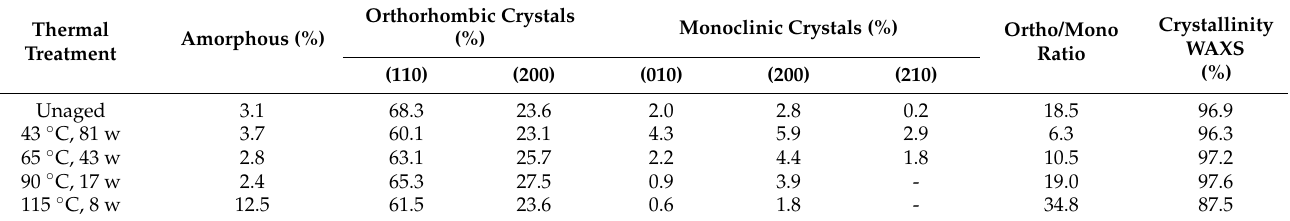
Table 2. Summary of the estimates of the crystallinity and crystal phase percentages for the or- thorhombic and monoclinic crystals present in the control and the thermally aged UHMMPE fibers as calculated from the fitting of WAXS